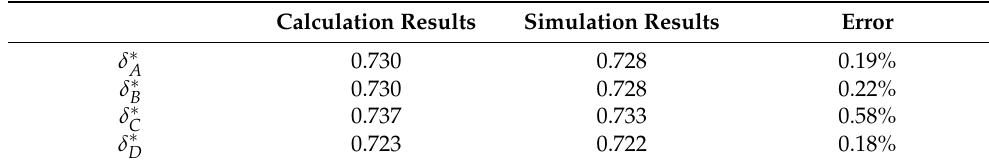
Table 4. The static deformation of the